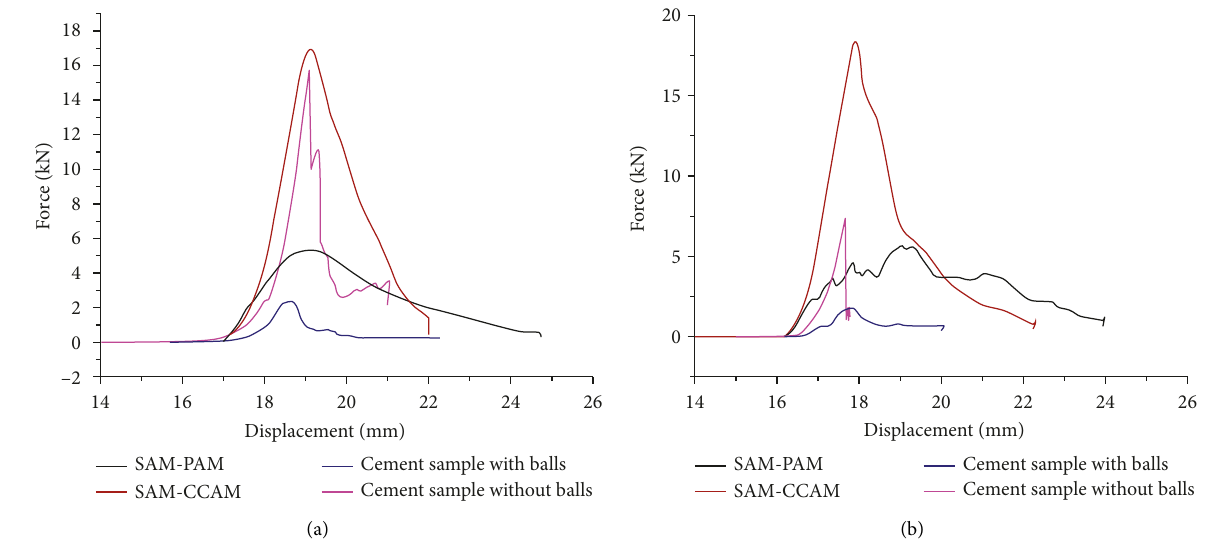
Figure 8: Force-displacement curves of samples from the IDT test. (a) 15 ° C. (b)